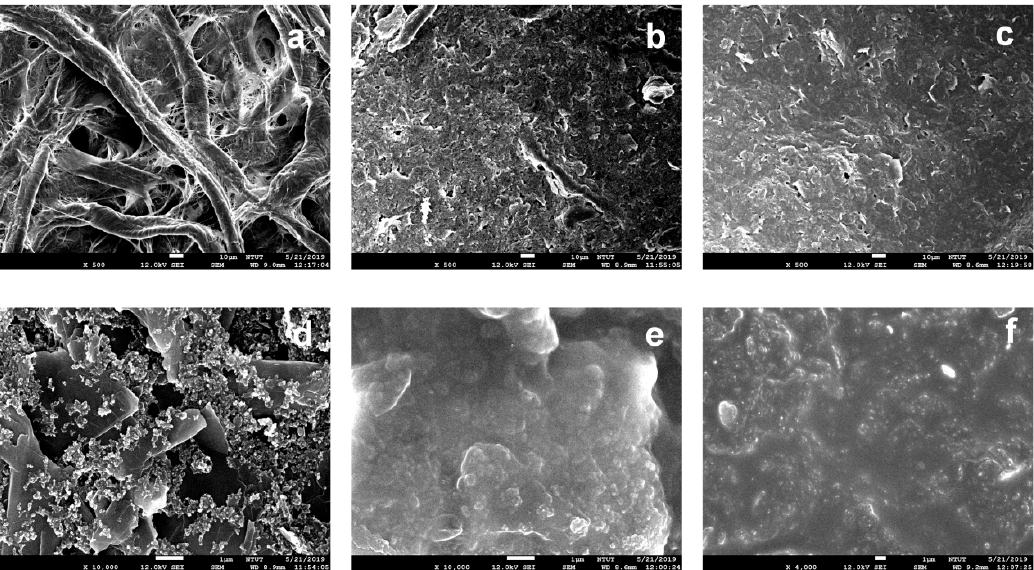
Figure 2. SEM images at 500× magnification of unmodified Whatman grade No. 3 filter paper ( a ) And filter paper modified with: ( b ) Graphene ink, ( c ) Graphene/PEDOT:PSS. SEM images at 10,000× magnification of the filter paper modified with: ( d ) Graphene ink, ( e ) Graphene/PEDOT:PSS, and ( f ) Graphene/PEDOT:PSS with methanol treatment.